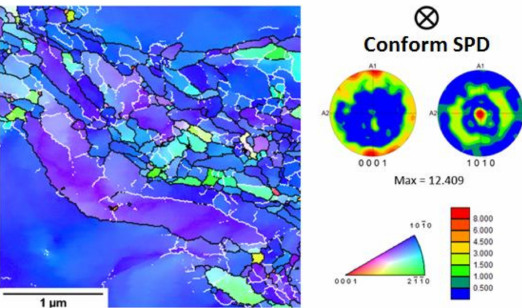
Figure 7. Transmission EBSD map of the sample after one Conform SPD pass and rotary swaging (3 × 3 µ m). High-angle grain boundaries (>15 ◦ ) are marked by black lines, while the low-angle grain boundaries (between 4 ◦ and 15 ◦ ) are marked by white lines. The texture intensities are carried out as the multiples of random density (m.r.d.) from 0–8.000, with maximum at 12.409